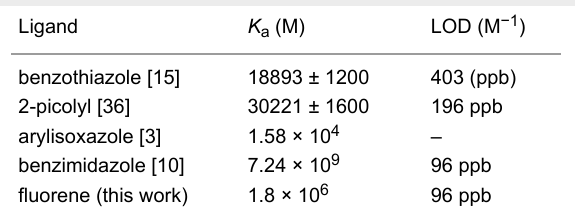
Table 1: Comparison of lower rim 1,3-diconjugate derivatives of calix[4]arene with chemosensor L